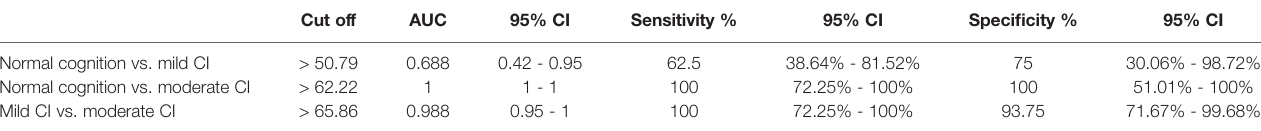
AUC, the area under the curve; CI, con fi dence interval; mild CI, mild cognitive impairment; moderate CI, moderate cognitive